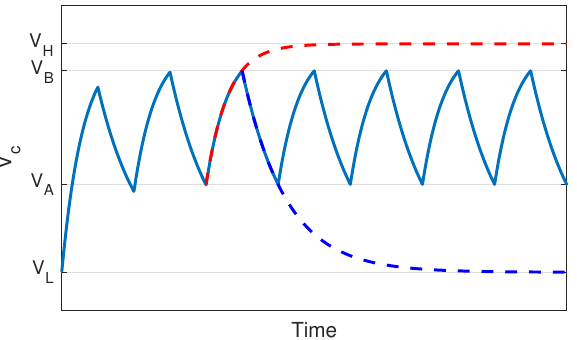
Figure A3. V c versus time for the circuit in Figure